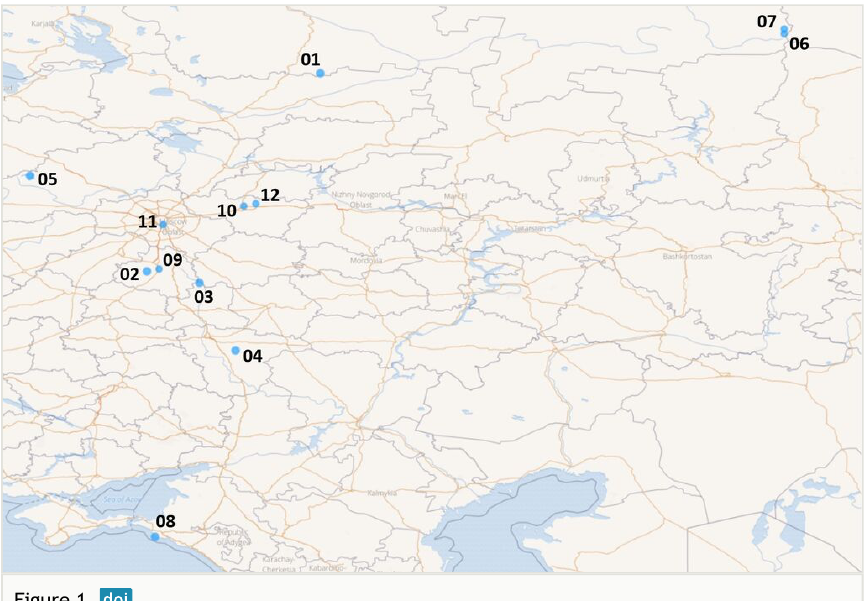
Distribution of the sampled local floras across European Russia: 01 - Ustya, Arkhangelsk Oblast; 02 - Zaseki, Tula Oblast; 03 - Polibino, Lipetsk Oblast; 04 - Khrenovoye, Voronezh Oblast; 05 - Troyeruchitsa, Tver Oblast; 06 - Man-Pupu-Ner, Komi Republic; 07 - Middle Lyaga, Komi Republic; 08 - Utrish, Krasnodar Krai; 09 - Yasnaya Polyana, Tula Oblast; 10 - Bogolyubovsky Lug, Vladimir Oblast; 11 - Tsaritsyno, City of Moscow; 12 - Patakino, Vladimir Oblast. Source: Seregin